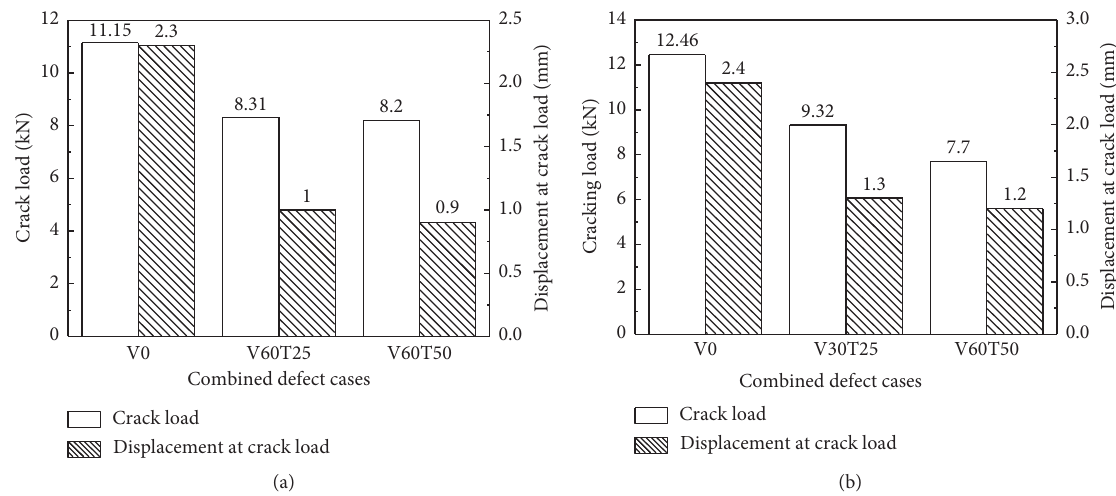
Figure 14: Crack load and displacement at the crack load of the lining with combined defects: (a) crown and (b) spandrel.